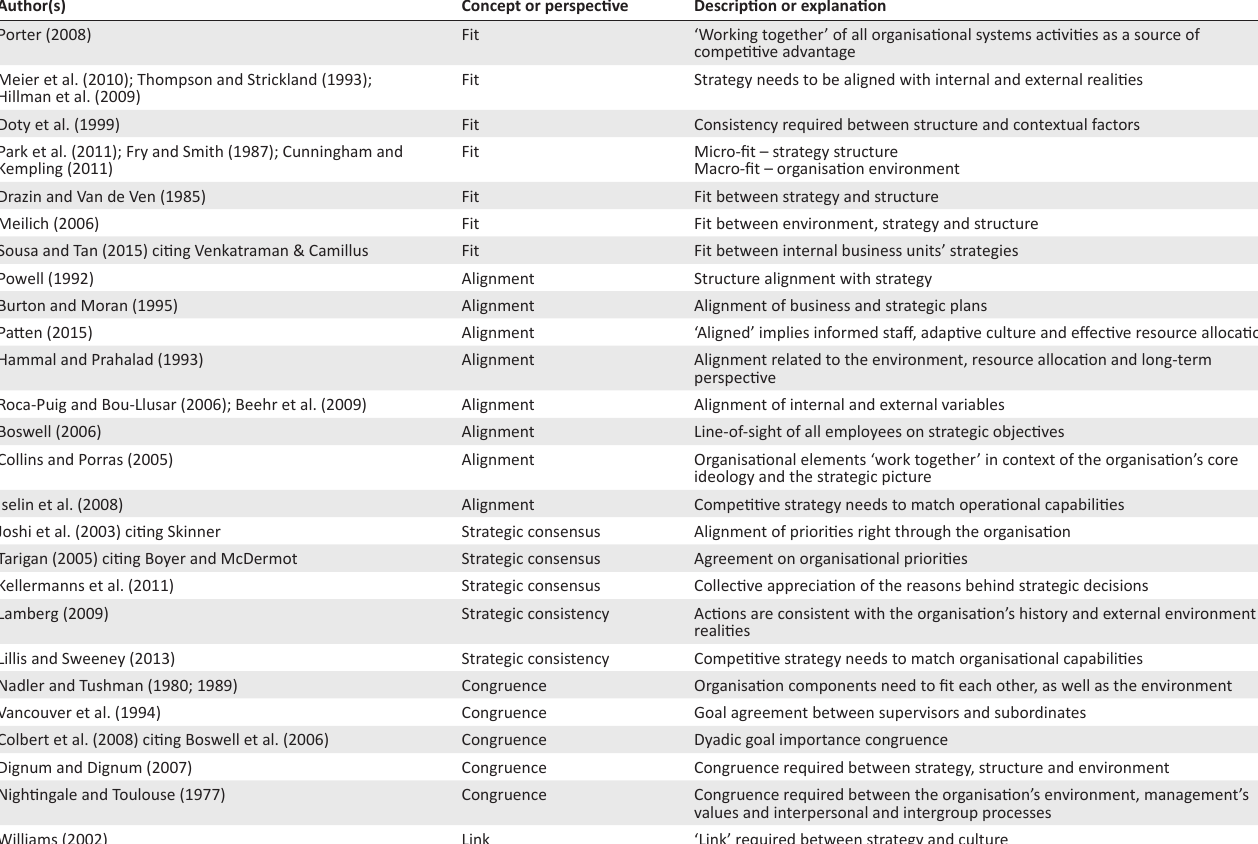
TABLE 1: Organisational alignment studies.